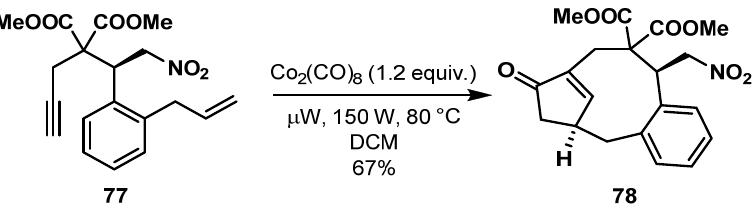
Scheme 33. Li’s asymmetric total synthesis of bufospirostenin